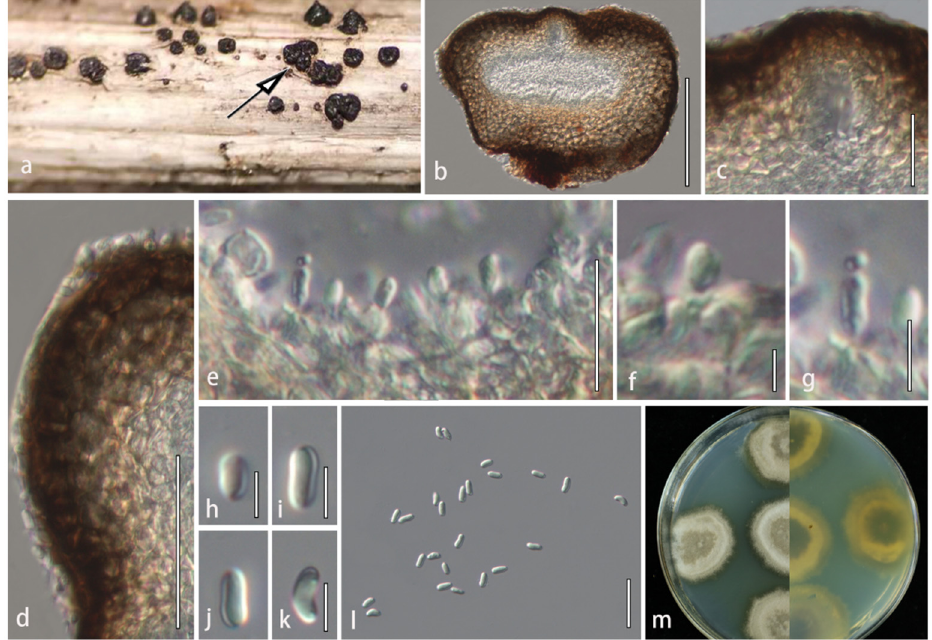
Figure 4. Plenodomus changchunensis (HMJAU 60186, holotype). ( a ) Appearance of conidiomata on host substrate; black arrow indicates the conidiomata of P. changchunensis on the host. ( b ) Vertical section of conidioma. ( c ) Ostiolar canal. ( d ) Section of conidioma wall. ( e – g ) Conidiogenous cells and conidia. ( h – l ) Conidia. ( m ) Culture characteristics on PDA after three weeks at 25 °C. Scale bars: ( b ) = 100 µ m; ( c , e , l ) = 20 µ m; ( d ) = 50 µ m; and ( f – k ) = 5 µ m.